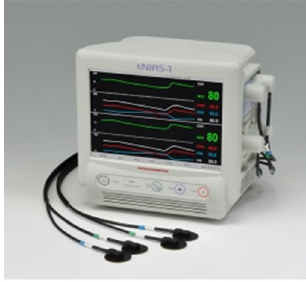
Figure 12. Photo of tNIRS-1.